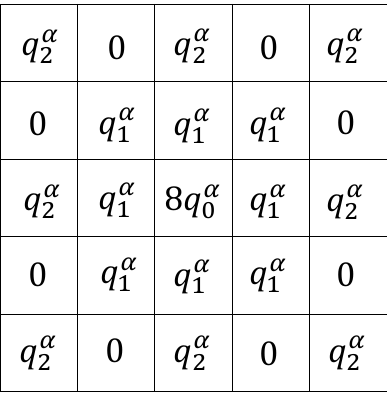
Figure 5. A four-direction fractional order differentiator